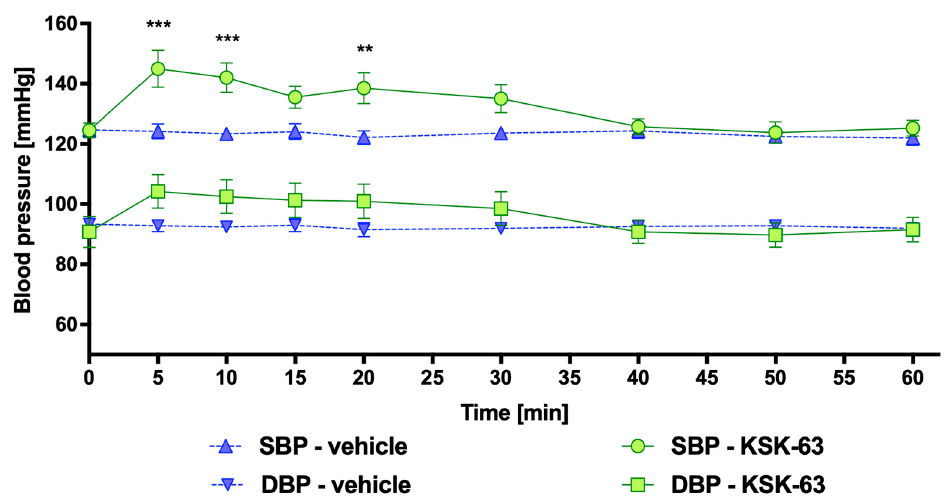
Figure 4. Effect of KSK-63 on blood pressure after a single administration (10 mg/kg i.p.). Results are presented as mean ± SEM, n = 6. Statistical analysis: two-way ANOVA with repeated measures, Bonferroni’s post hoc tests, ** p < 0.01; *** p < 0.001 vs. vehicle group. SBP—systolic blood pressure; DBS—diastolic blood pressure.